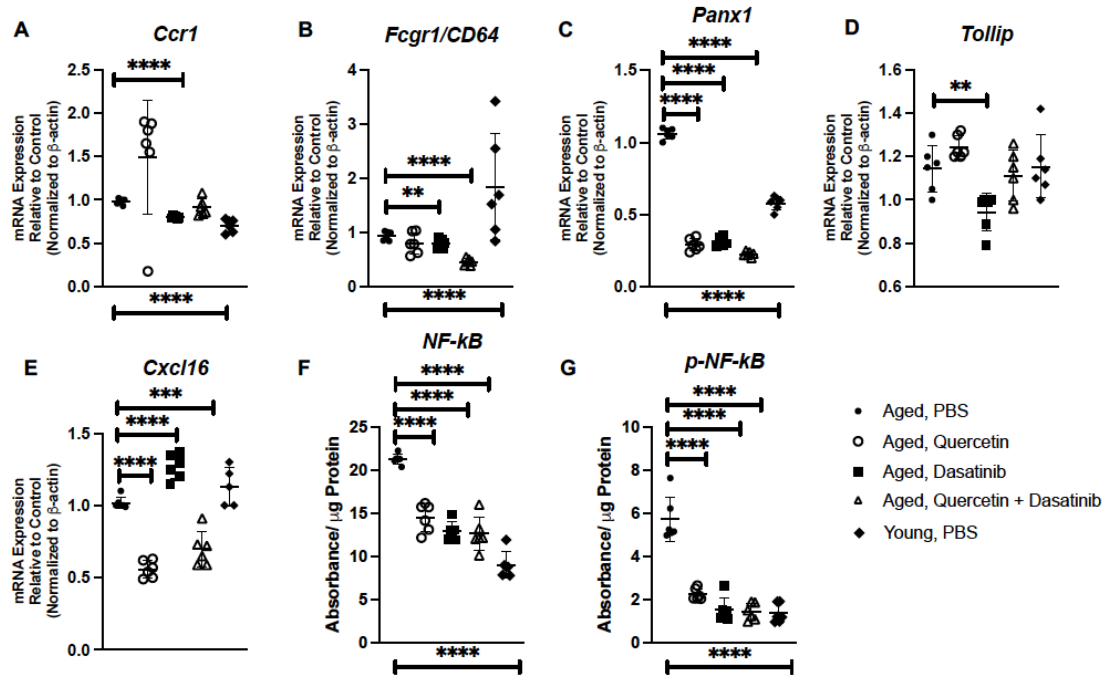
Figure 5. Senolytic Treatment of Aged Mice Alters Inflammatory Gene Expression in Aged Lung. Lung tissue was collected from PBS-, quercetin-, dasatinib-, and quercetin + dasatinib-treated aged adult BALB/c mice (20 months of age). Expressions of ( A ) Ccr1, ( B ) Fcgr1/CD64 , ( C ) Panx1, ( D ) Tollip , and ( E ) Cxcl16 were assessed by real-time PCR. Protein expression of ( F ) NF- B and ( G ) p-NF- B in aged lung was assessed by PathScan ELISA. N = 6 mice per group, and the experiment was repeated 3 times. Young (3 months) PBS-treated lung expression analysis is included for comparison. ** p < 0.01, *** p < 0.001, and **** p < 0.0001.